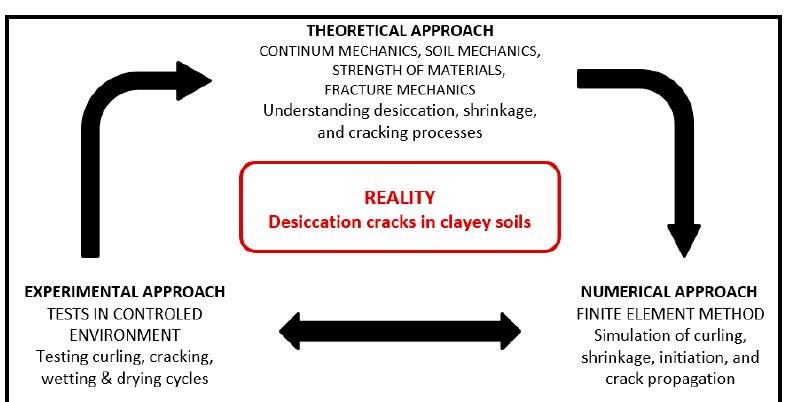
Figure 1. A theoretical, numerical, and experimental approach to the desiccation crack problem in clayey soils.